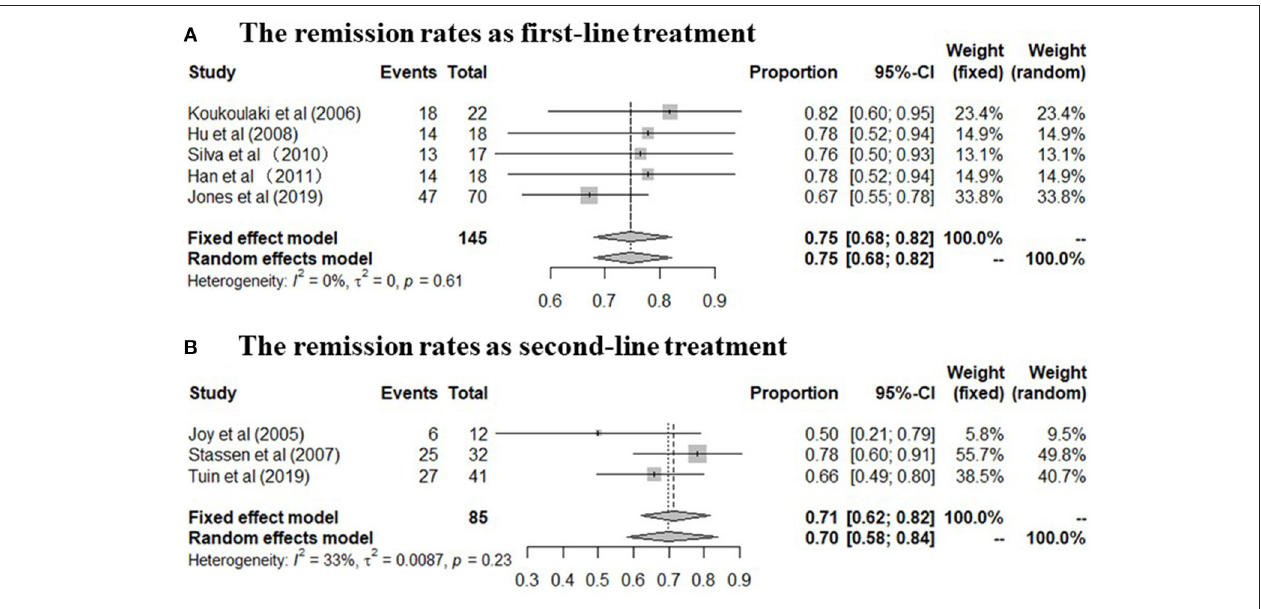
FIGURE 4 | (A,B) The remission rate in patients undergoing MMF treatment in the included studies (The forest plots was mapped based on the use of MMF as first-line or second-line treatment).